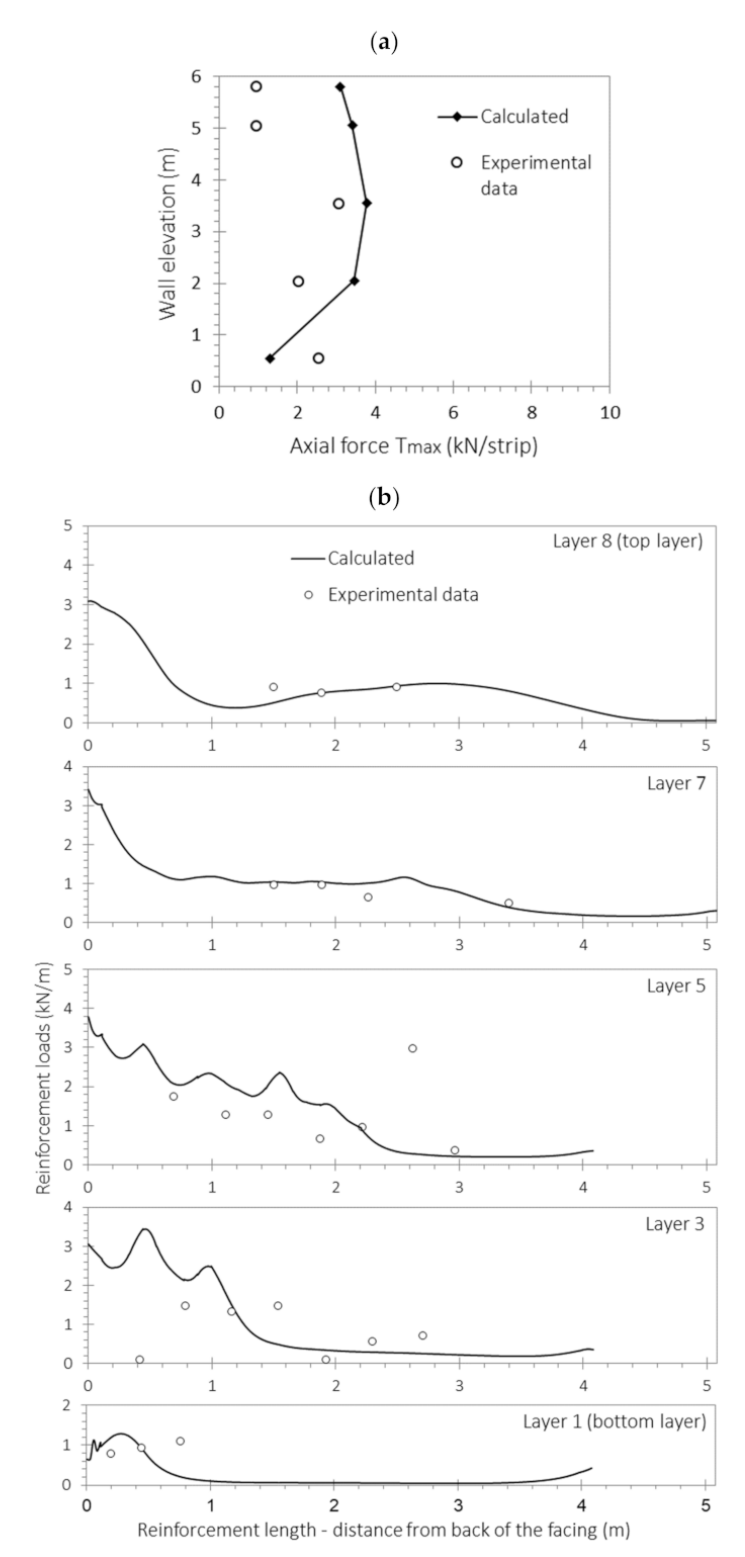
Figure 6. Comparison between the FE model results and the experimental data [24]: ( a ) maximum reinforcement axial force per strip, and ( b ) distribution of axial force along reinforcement